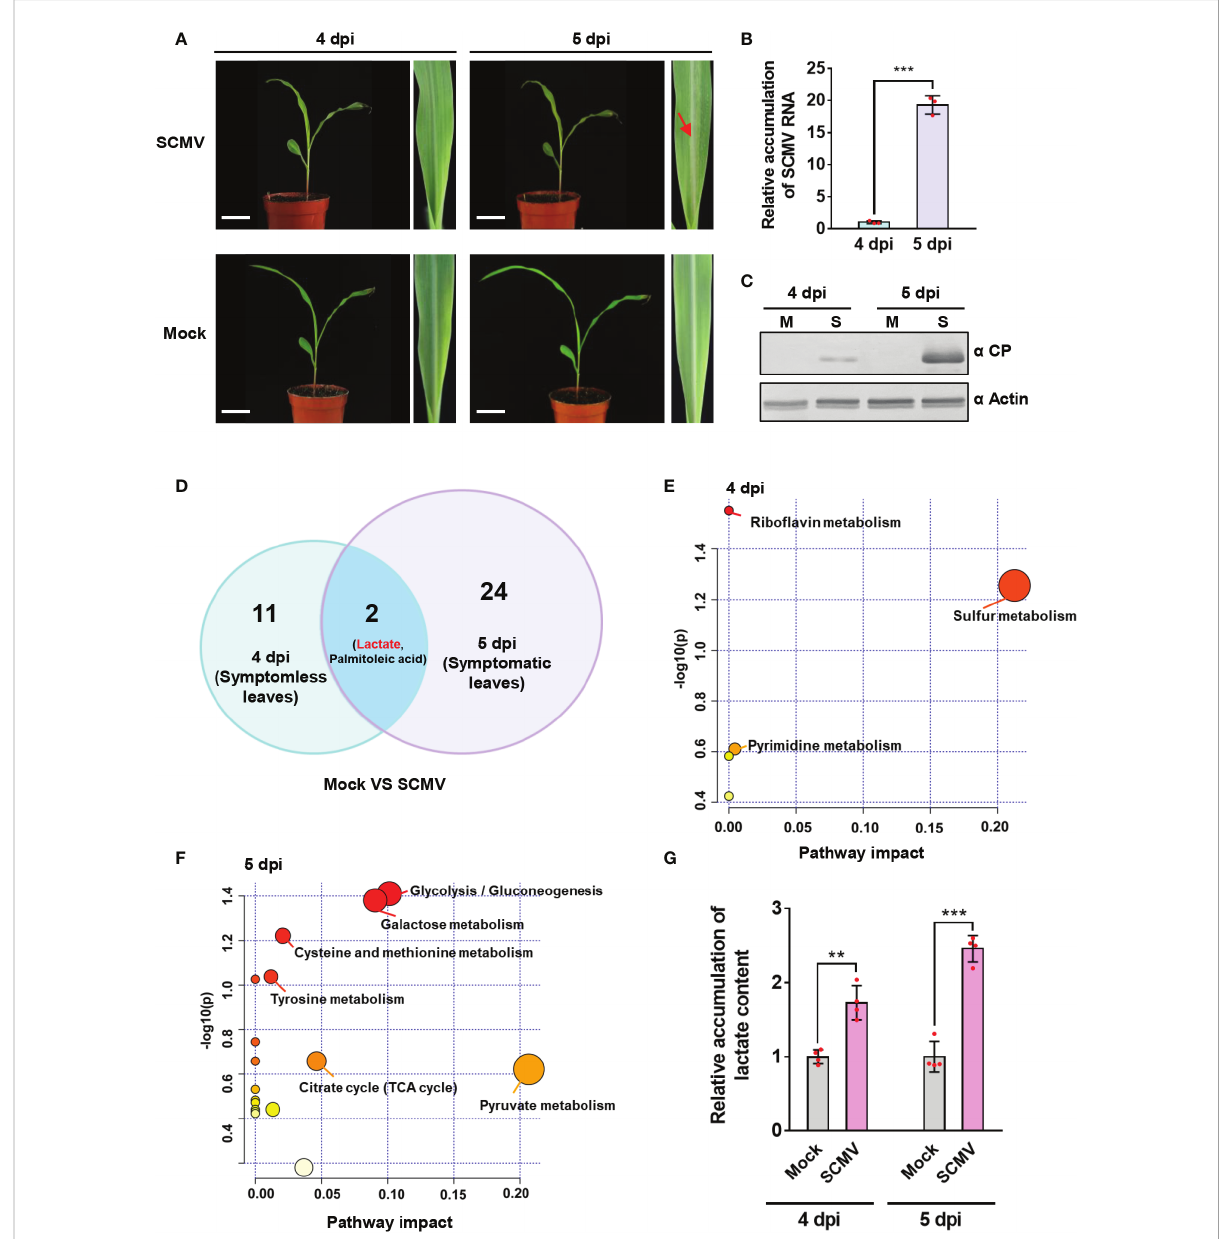
FIGURE 1 Untargeted metabolomics analysis showed signi fi cant lactate accumulation at 4- and 5-day post inoculation (dpi) of sugarcane mosaic virus (SCMV). (A) Maize plants and the fi rst systemically infected maize leaves (1 SLs) of mock-inoculated or SCMV-infected maize plants at 4 and 5 dpi. Maize leaves (n=6) were harvested, pooled, and used for untargeted metabolomics analysis. Red arrow indicates the manifestation of mosaic symptoms. Scale bars = 4 cm. (B) Relative accumulation levels of SCMV genomic RNA in 1 SLs determined by RT-qPCR at 4 and 5 dpi. The results are represented as the means ± SE (n=3). Statistical differences between the treatments were determined using unpaired Student ’ s t -test (two-tailed), *** P < 0.001. (C) Accumulation levels of SCMV coat protein (CP) in 1 SLs at 4 and 5 dpi through western blotting analysis. The actin bands in the lower panels are used to show sample loadings. M, Mock; S, SCMV. (D) Venn diagram displaying the numbers of differentially expressed metabolites identi fi ed at 4 dpi and 5 dpi. Lactate and palmitoleic acid were found in both groups. (E) Pathway enrichment analysis (GlobalTest) combined with pathway topology analysis (degree centrality and betweenness centrality) for SCMV-infected plants compared with mock-inoculated plants at 4 dpi. Metabolites are clustered in nodes with pathway impact on the X axis calculated by pathway topology analysis and plotted according to – log ( p ) values on the Y axis. SCMV-infected plants demonstrated multiple large nodes of altered metabolic pathways compared with mock-inoculated plants. (F) Pathway enrichment analysis (GlobalTest) combined with pathway topology analysis (degree centrality and betweenness centrality) for SCMV-infected plants compared with mock-inoculated plants at 5 dpi. (G) Relative accumulation of lactate contents in the Mock- or SCMV-infected samples harvested at 4 or 5 dpi through LC-MS/MS. The data are represented as the means ± SE (n=4). Statistical differences between the treatments were determined using unpaired Student ’ s t -test (two-tailed), ** P < 0.01; *** P <